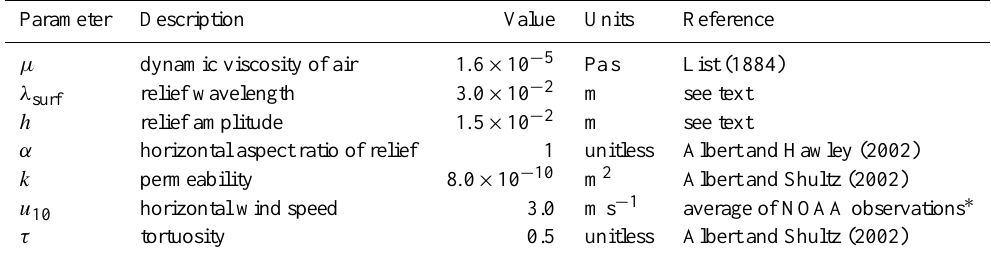
Table 1. Parameters to calculate the vertical wind pumping speed and diffusion a Summit, Greenland.